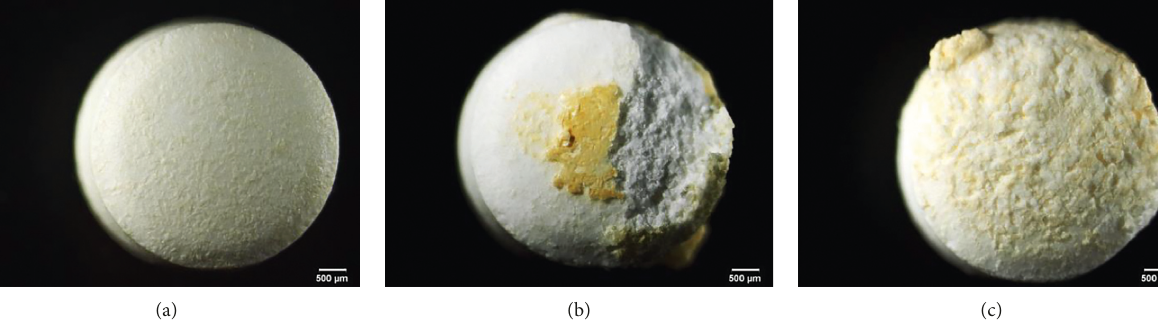
Figure 4: Stereomicrographs: experiment A1—well-coated tablet versus badly-coated tablet (both sides).